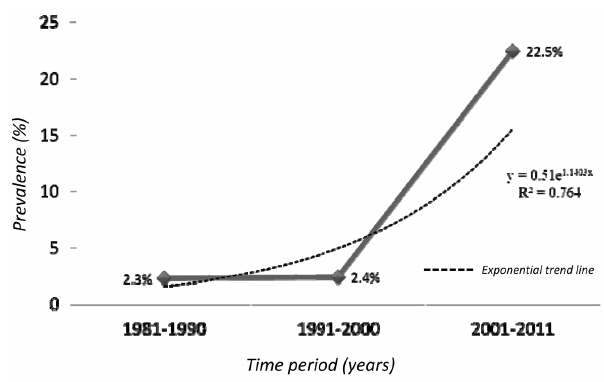
Figure 3. Trends in hypertension prevalence (1981–2011).